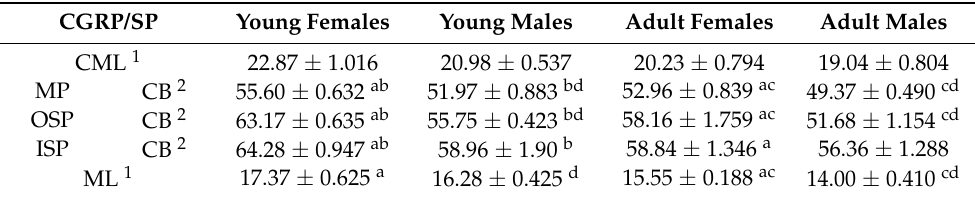
Table 2. The co-localization of CGRP with substance P (SP) in the enteric nervous structures of the porcine descending colon under physiological conditions in young (10-week old) females and males and adult (6–8 months old) females and males.